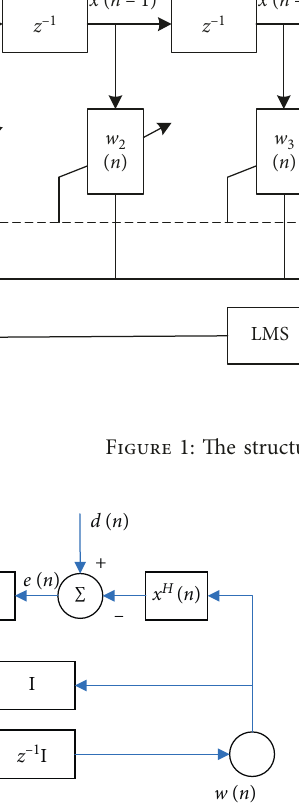
Figure 2: The signal flow diagram of the LMS